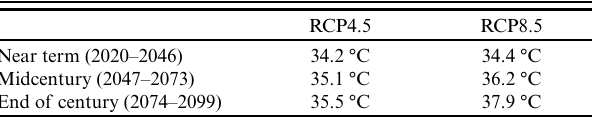
Table 1 . Projected 95th percentile daily summer air temperature (°C) calculated with the U.S. Department of